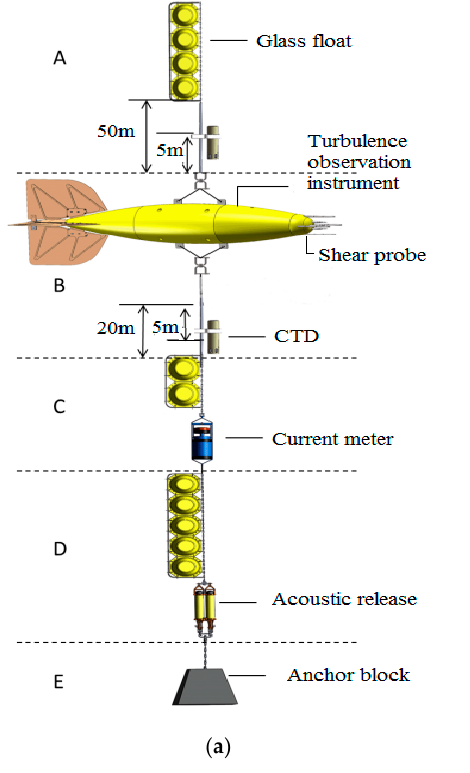
Figure 1. The self-designed MTMI. ( a ) The main structure of the MTMI; ( b ) the field test location of the whole observation platform in the South China Sea.